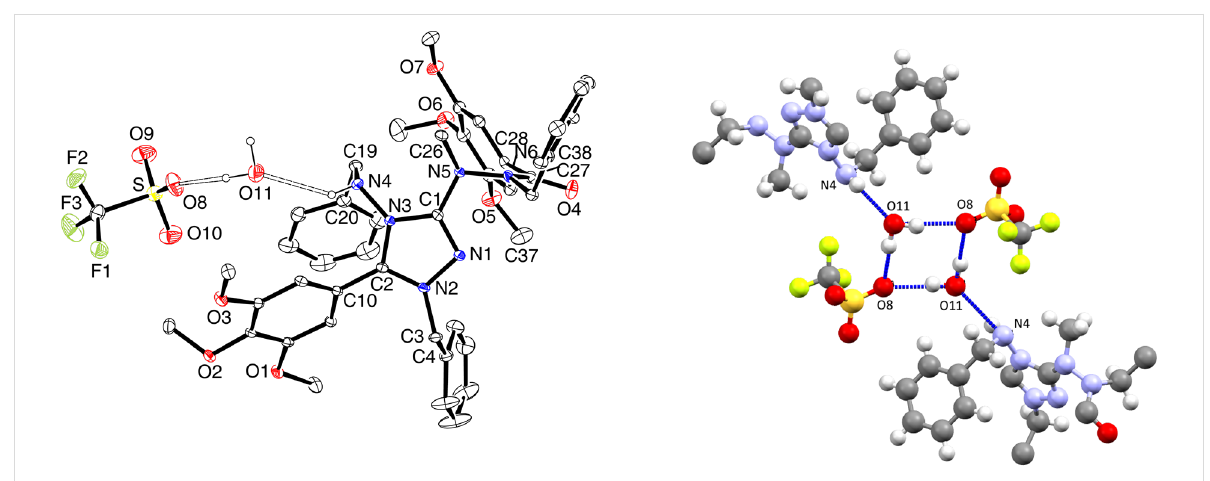
Figure 3: Left: solid-state structure of 9b ·H 2 O (ORTEP plot). Right: centrosymmetric hydrogen-bonded dimer of (CF 3 SO 3 ) − ·H 2 O (Mercury plot); the substituents at the triazole ring are not complete. Selected bond lengths (Å): C1–N1 1.309(3), C1–N3 1.376(3), C1–N5 1.376(3), N1–N2 1.378(3), C2–N2 1.314(3), C2–N3 1.366(3), N3–N4 1.400(3). Hydrogen bonds: N4–H···O11, N4–H 0.89(4) Å, N···O11 2.946(3) Å, H···O11 2.22(4) Å, <(N4–H···O11) 139(3)°; O11–H b ···O8, O11–H b 1.01 Å, O11···O8 3.023(4) Å, H b ···O8 2.02 Å, <(O11–H b ···O8) 170°; O11–H a ···O8 (1 − x , 1 − y , 1 − z